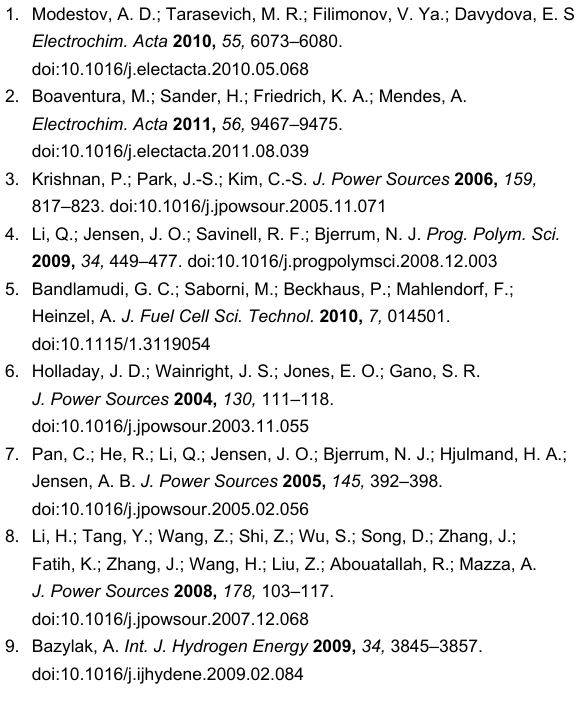
ates and gas pores with much lower conductivities. The average surface conductivity of the sprayed electrode is higher than that of the coated one. The PTFE distribution within the electrode is sensitive to its preparation technique. During spraying the small droplets of the catalyst ink dried instantly on the GDL, which resulted in a homogeneous PTFE distribution in the catalyst layer. In contrast, the drying process of the coated electrode took up to 12 h, during which the light PTFE particles could migrate to the top region of the catalyst layer and form a nonconductive “skin” on the electrode surface. This PTFE-rich layer affects not only the surface conductivity but also the wettability of the catalyst layer. The high PTFE content created a hydrophobic electrode surface, which slowed down the phos- phoric acid uptake during the start-up period of the